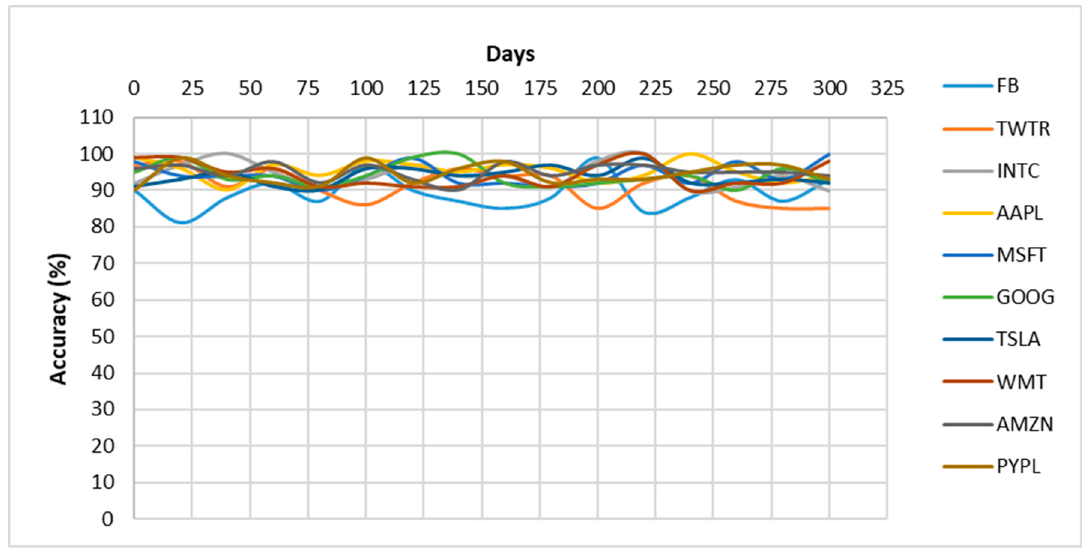
Figure 10. Accuracy timeline.